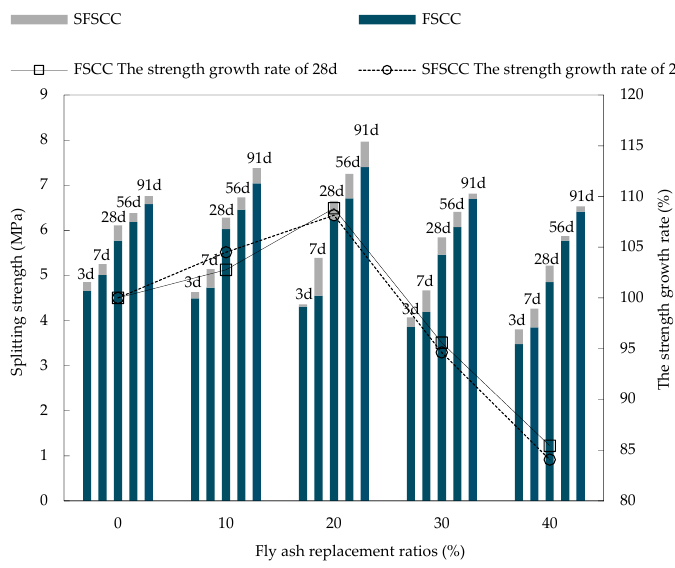
Figure 6. Results of SCC splitting strength test. Table 6. Test results of 3 days, 7 days and 28 days splitting strength of SCC.